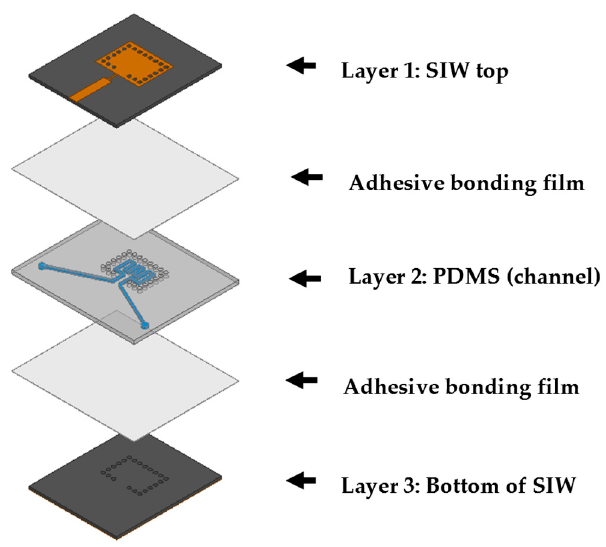
Figure 3. Layers of the proposed SIW chemical sensor.